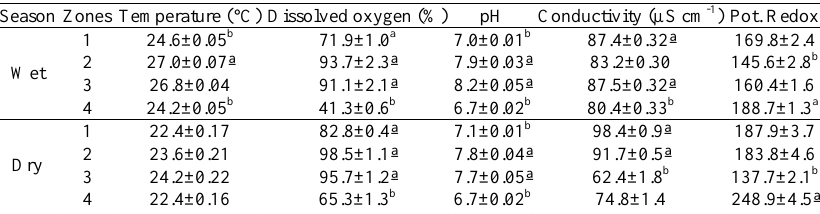
Table 4. Abiotics data (mean ± s.d.) from four zones of the Paraíba do Sul River - Funil Reservoir system during the wet and dry seasons. n = 20 for each zone in each season. Superscript letters indicate significant (p < 0.05) differences according to ANOVA. Season Zones Temperature (°C) Dissolved oxygen